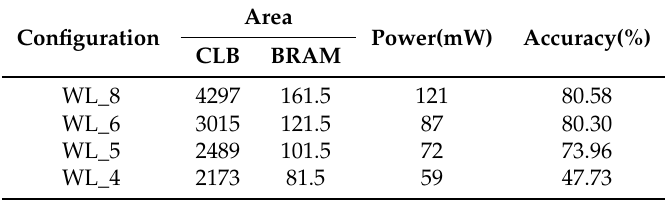
Table 3. Area, Power and accuracy results for SVHN configurations.